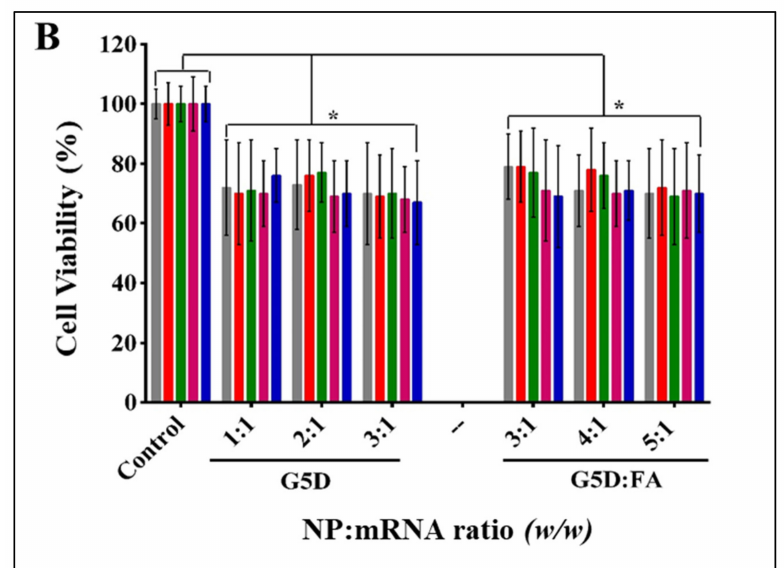
Figure 7. Cell viability assay of nanocomplexes containing ( A ) Au:G5D and Au:G5D:FA; and ( B ) G5D and G5D:FA, in HEK293, HepG2, Caco-2, MCF-7, and KB cells. Cells were incubated with